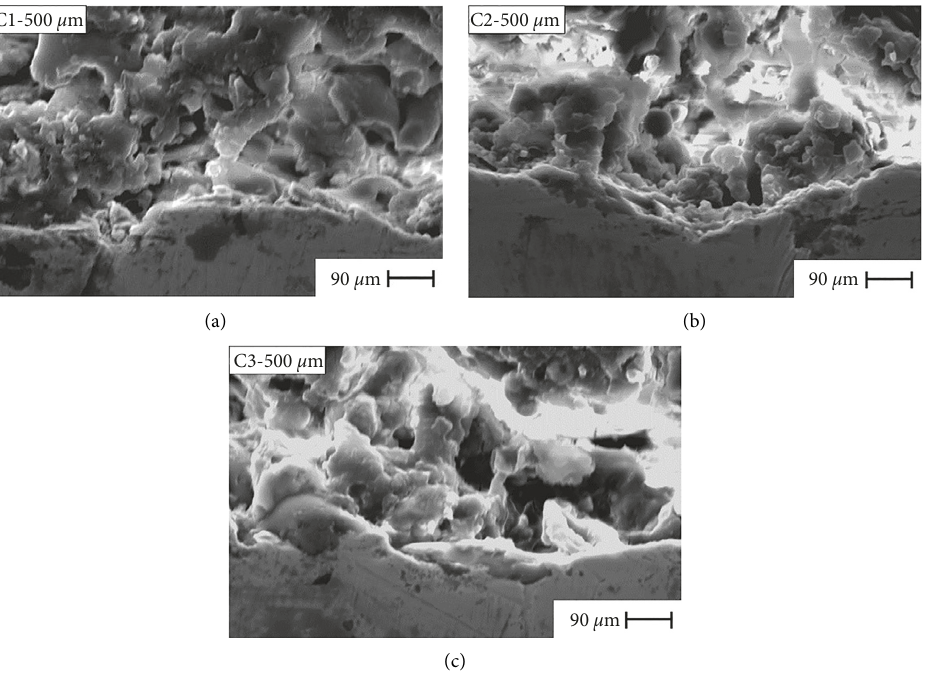
Figure 13: Cross section microstructure of coating (C). (a) C1. (b) C2. (c) C3.